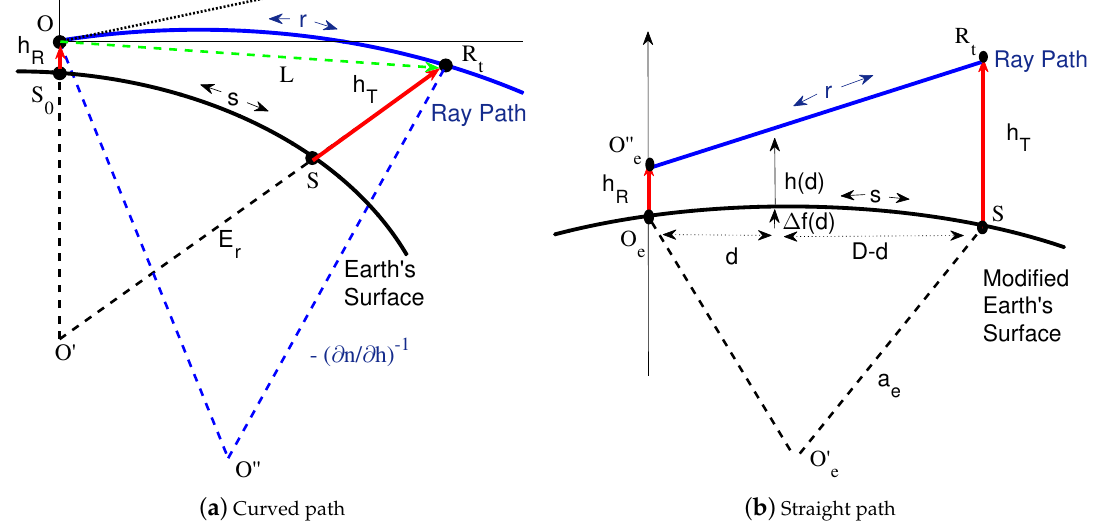
Figure 3. Geometry between the Earth’s surface and the ray path taking into account the vertical gradient of the refractivity. ( a ) ray path in a spherically stratified atmosphere along the Earth’s surface; ( b ) straight path of the ray above the equivalent Earth of radius a e